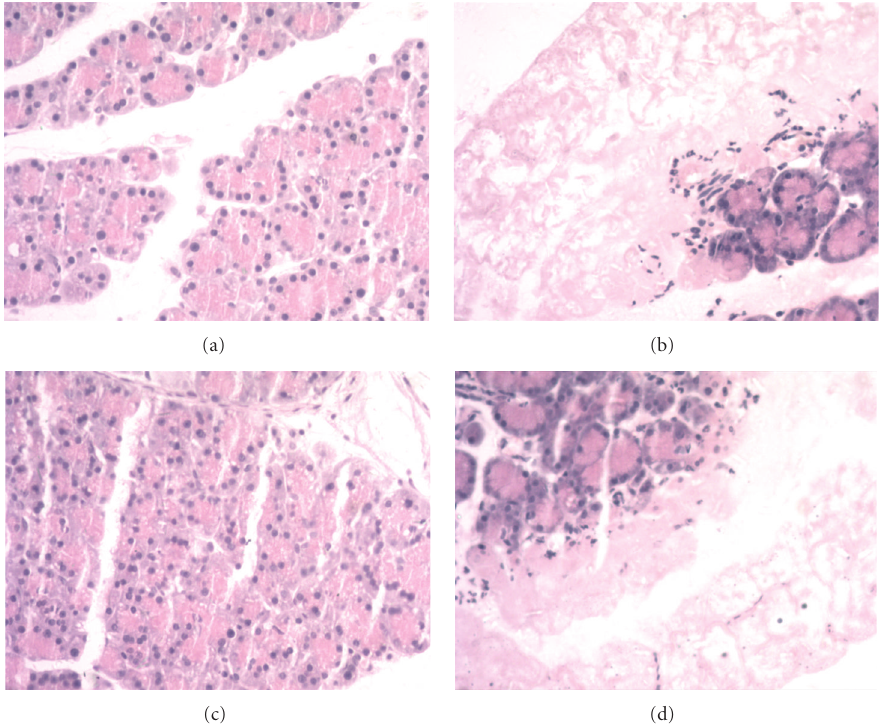
Figure 7: Pathological changes in the pancreas. (a) Sham, (b) SAP, (c) SAP + LP17, (d) SAP + TY17.